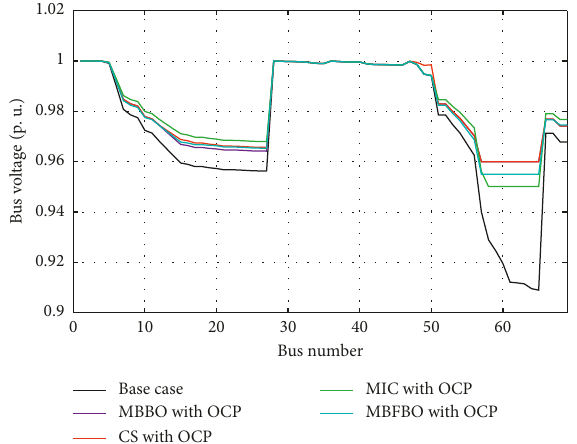
Figure 7: Voltage profile for 69-bus RDS using OCP technique.